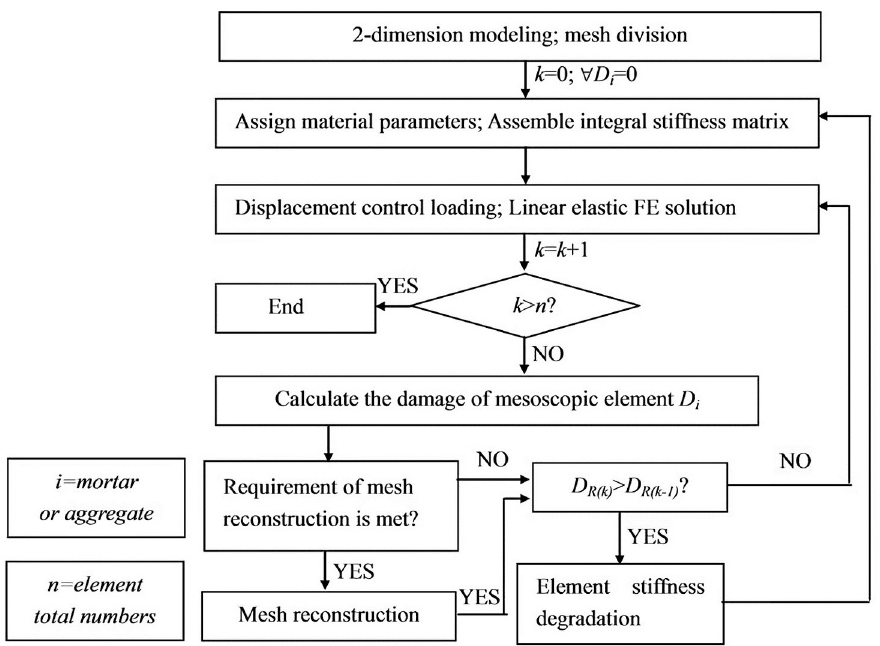
Fig 6. Flow of multi-scale modeling. The failure process under static action is analyzed using the multi-scale model, and the displacement load is applied increment by increment. The displacement of each increment is 0.005mm and n increments are totally loaded. At the end of each step loading, it is necessary to judge twice the damage state of the each element in the model.